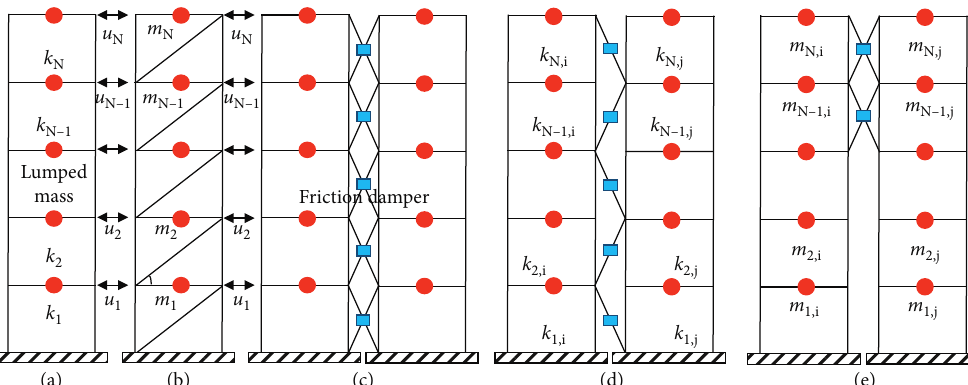
Figure 1: Mathematical models of N -storey: (a) unconnected (U) moment-resisting frame (MRF), (b) unconnected (U) braced frame (BF), (c) connected frames (configuration A), (d) connected frames (configuration B), and (e) connected frames (configuration C) for equal storey height.